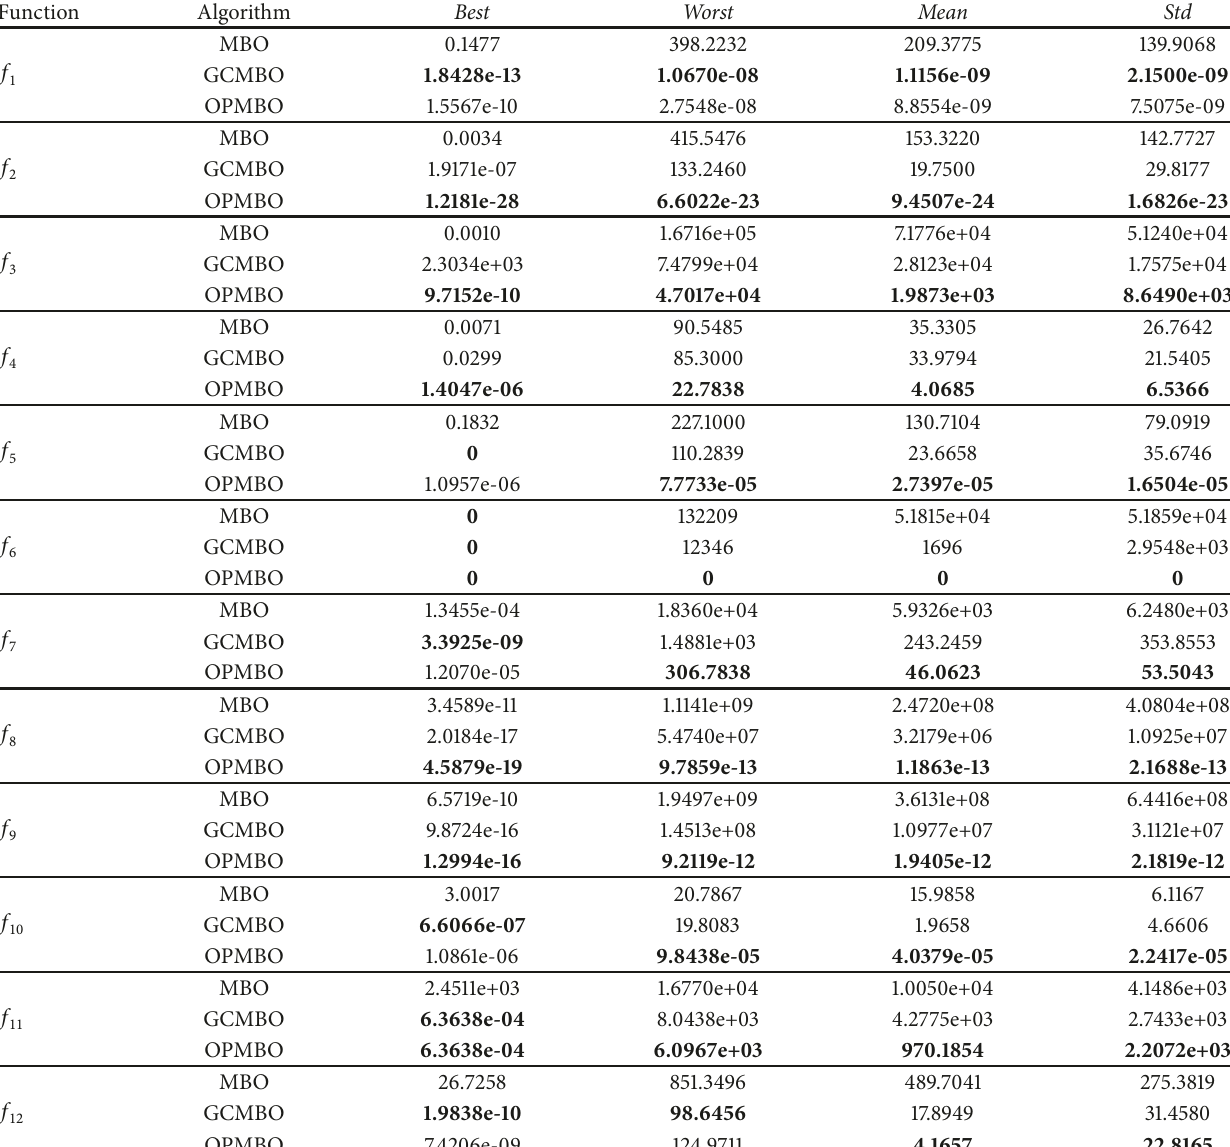
Table 4: The comparison results of the three algorithms on the 50-dimensional benchmark functions.